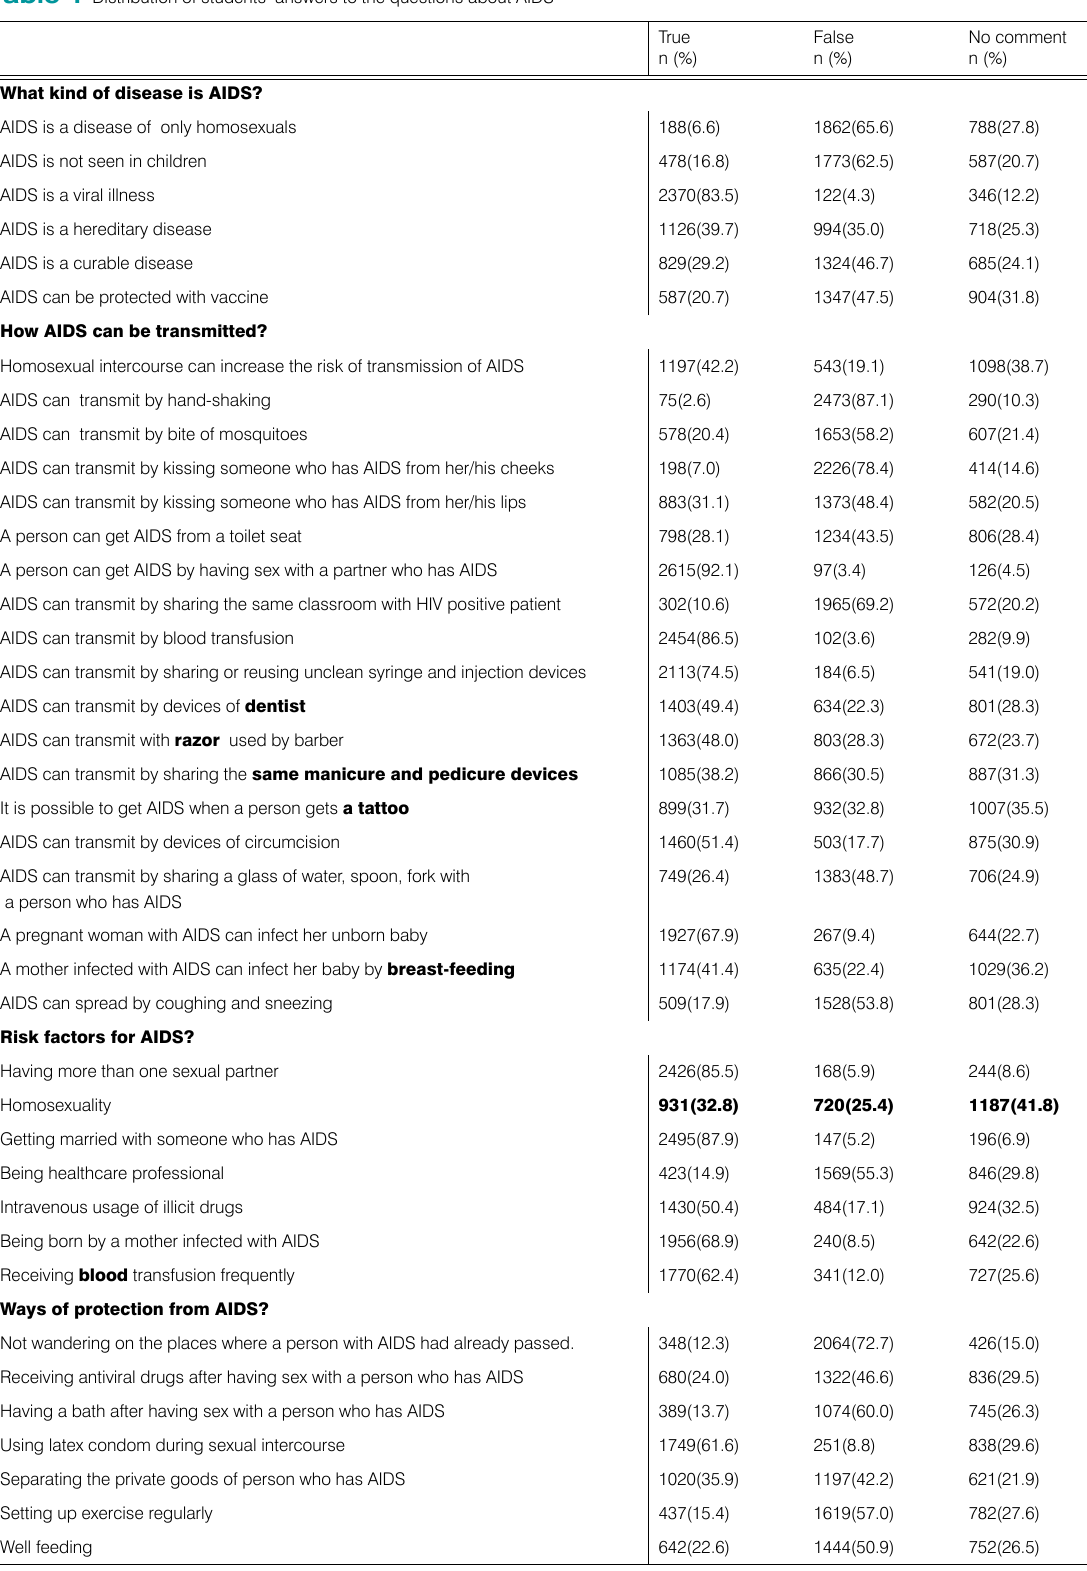
Table 1 Distribution of students’ answers to the questions about